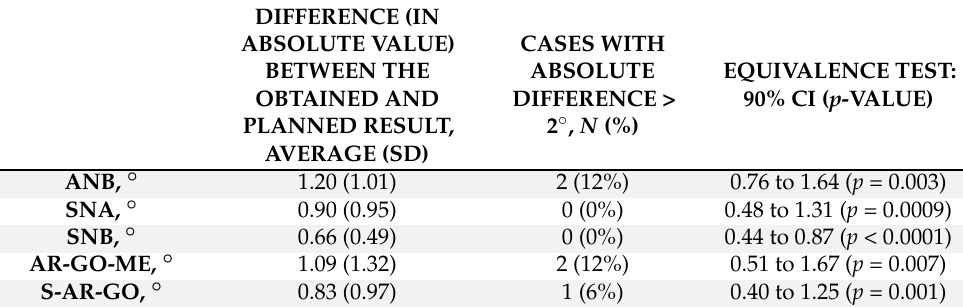
Table 2. Group A: cleft lip and palate patients.